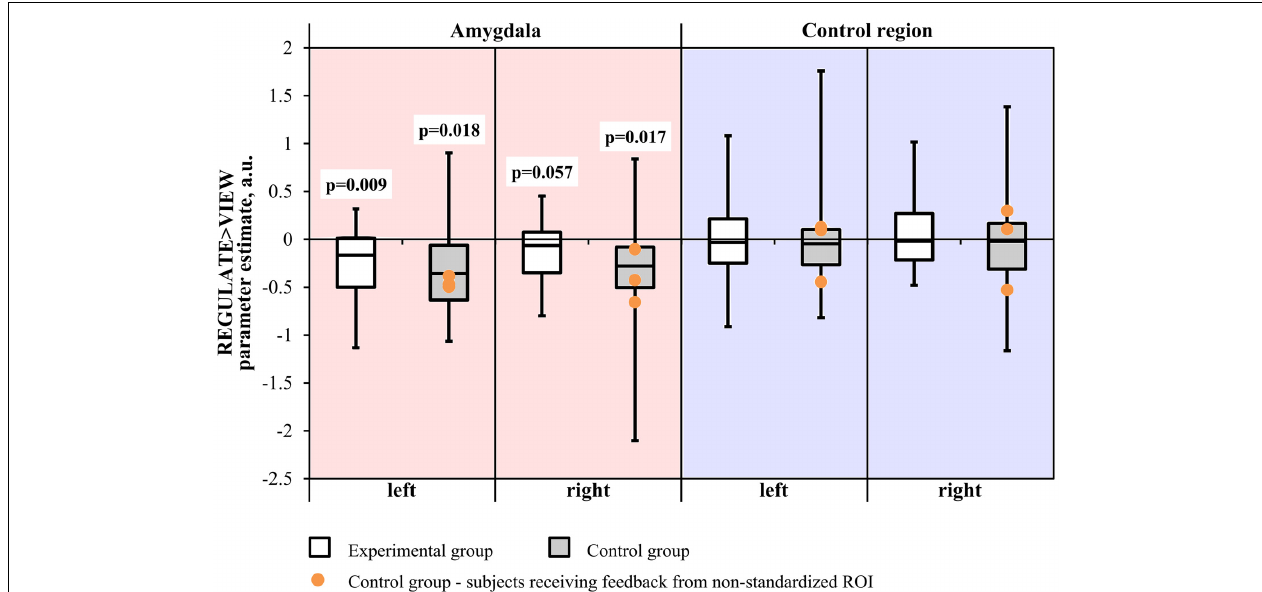
FIGURE 3 | Results of the region-of-interest analysis of the neurofeedback training. Negative values indicate a decrease of the BOLD signal amplitude in the regulate condition (REGULATE) compared to natural responding toward aversive pictures (VIEW). White box plots: participants receiving feedback from the amygdala during training (experimental group). Gray box plots: participants receiving feedback from